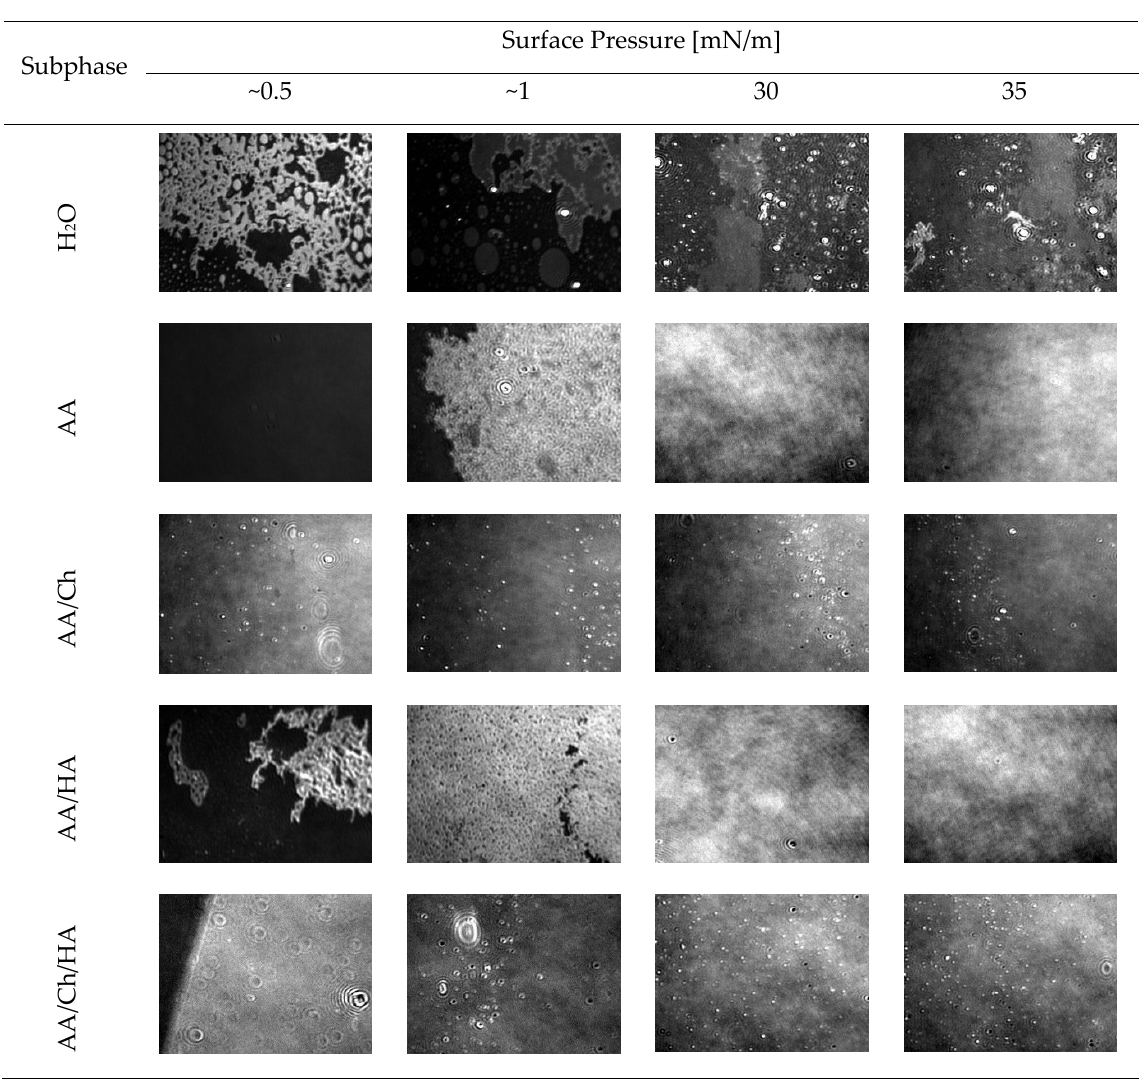
Figure 3. Structure of the DPPG monolayers during their compression (at surface pressures of 0.5, 1, 30 and 35 mN/m) on the different subphases (AA–acetic acid, AA/Ch–chitosan on acetic acid, AA/HA–hyaluronic acid in acetic acid, AA/Ch/HA–chitosan in acetic acid with the addition of hyaluronic acid).